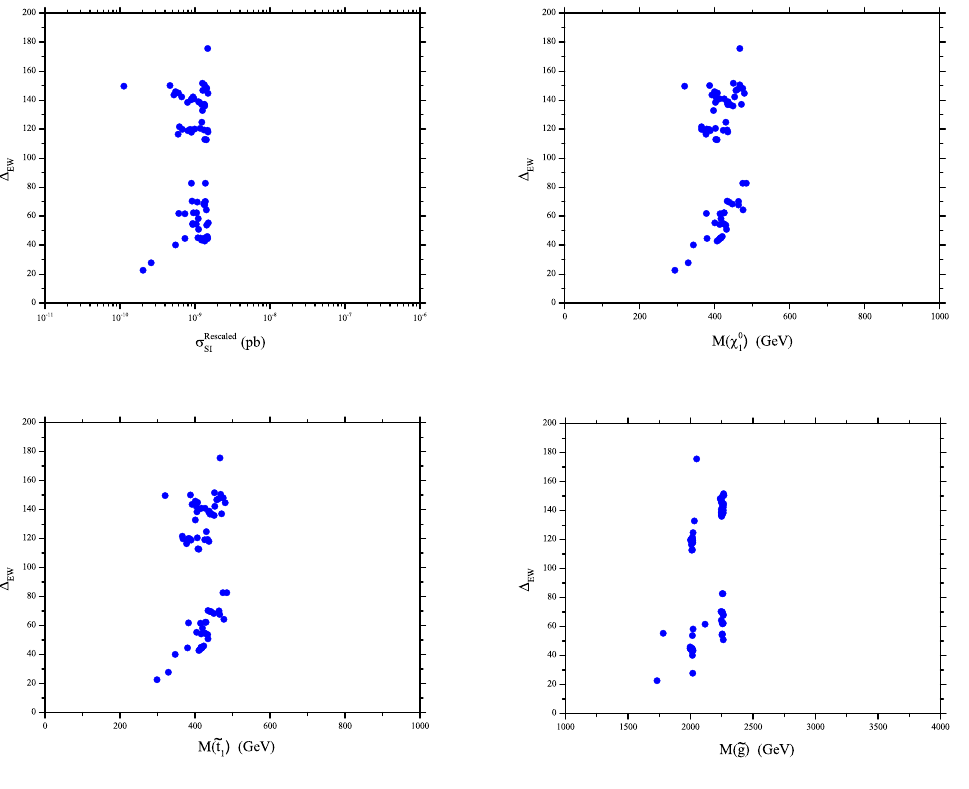
Figure 5 . Electroweak fine-tuning measure ∆ EW plot as a function of σ Rescaled and M ( g ) for the -SU(5) D-brane inspired naturalness region. The naturalness region in this F diagram involves the 74 points that satisfy M ( σ Rescaled 1 . 5 10 − 9 pb, and ∆ M ( e SI ≤ × that is at least 92% Higgsino, but no more than 98% Higgsino. The ∆ EW stem exclusively from either M 2 ( EW ) or µ 2 ( EW ). These plots highlight a region with ∆ EW < 30, regarded as low H u electroweak